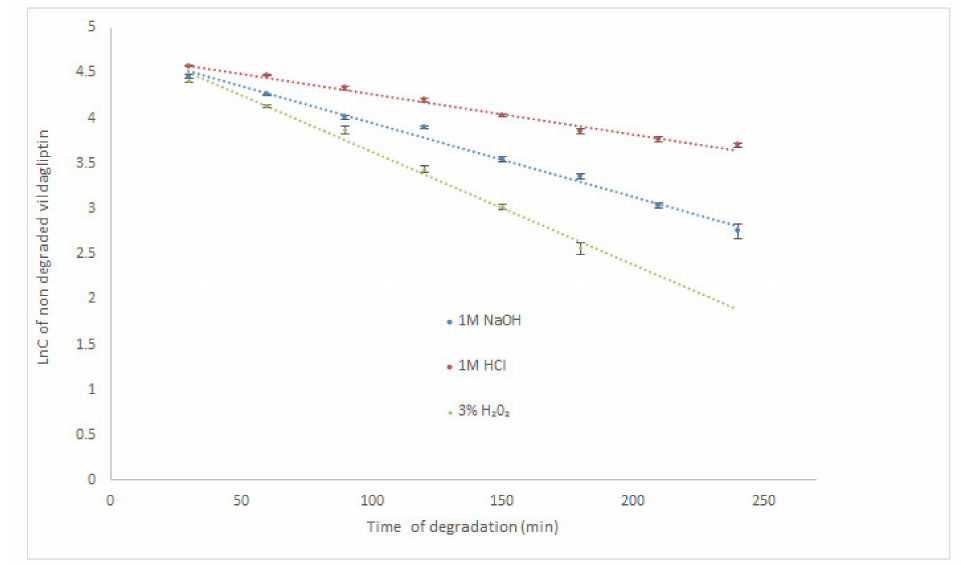
Figure 2. Pseudo first-order plots of degradation of vildagliptin in solutions at 23 ◦ C (mean ± SD, n = 3 for each time